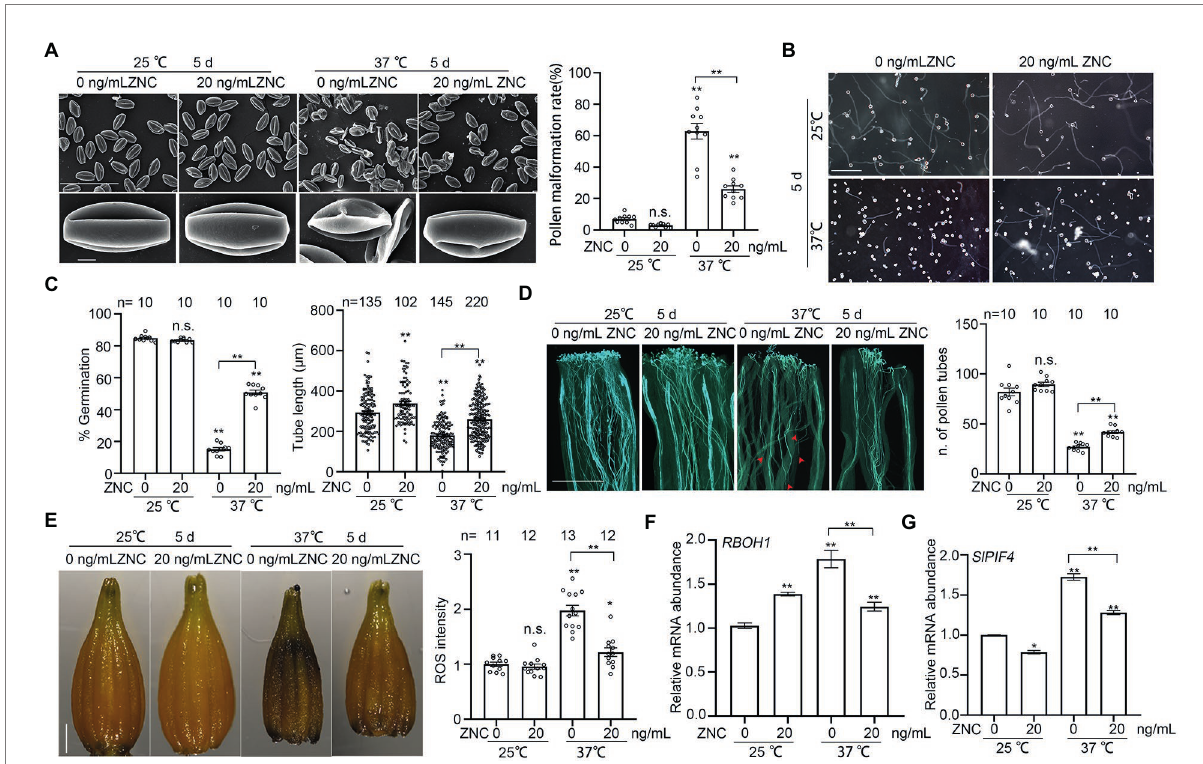
FIGURE 4 ZNC rescues long-term heat stress-induced pollen development defect. (A) Scanning electron microscope shows the morphology of pollen from plants with or without ZNC pretreatment, under 5 days of 25 ° C or 37 ° C treatment. Scale bar, 100 μ m (upper panel), 5 μ m (lower panel). (B) Growth of pollen tubes in vitro after 5 days of 25 ° C or 37 ° C treatment. Scale bar, 200 μ m. (C) Quantification of pollen germination and tube length in (B) . n denotes the number of observation views or pollen tubes. (D) Growth of pollen tubes in unstressed pistils after 5 days of 37 ° C treatment. Red arrows indicate the positions that pollen tubes reached. Scale bar, 500 μ m. n denotes the number of pistils. (E) NBT staining show the effect of ZNC pretreatment in alleviating ROS accumulation in anther. ROS intensity was measured by ImageJ and ROS in anthers at 25 ° C without ZNC treatment were set at 1 for comparative analyses. Scale bar, 1,000 μ m in D. n denotes the number of anthers. (F) Expression of RBOH1 in anther after 5 d at 25 ° C or 37 ° C treatment. (G) Expression of SlPIF4 in anther after 5 d at 25 ° C or 37 ° C treatment. Bars represent means ± SE m. Asterisk on the top of data bar indicates significant difference (two-tailed t -test, * p < 0.05, ** p < 0.01) compared with the data bar on the far left, while asterisk above the bracket represents comparison between the two data bars indicated. The symbol n.s. indicates no difference. All experiments have 3 biological replicates and they have similar